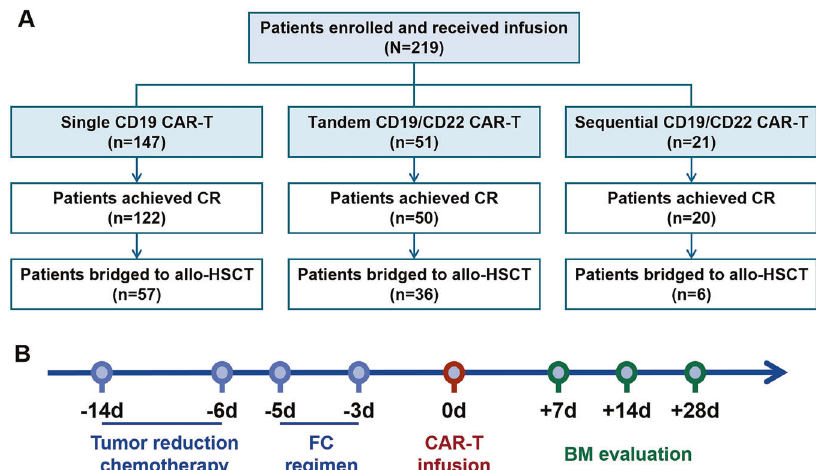
Fig. 1 Retrospective study cohort. A A total of 219 patients with R/R B-ALL successfully received CAR T-cell treatments (147 patients received single CD19 CAR T-cell therapy, 51 patients received tandem CD19/CD22 CAR T-cell therapy, and 21 patients received sequential CD19/CD22 CAR T-cell therapy) were screened in this study. Ninety-nine patients who achieved remission with CAR T-cell therapy bridged to allo-HSCT. B Schematic of CAR T-cell therapy